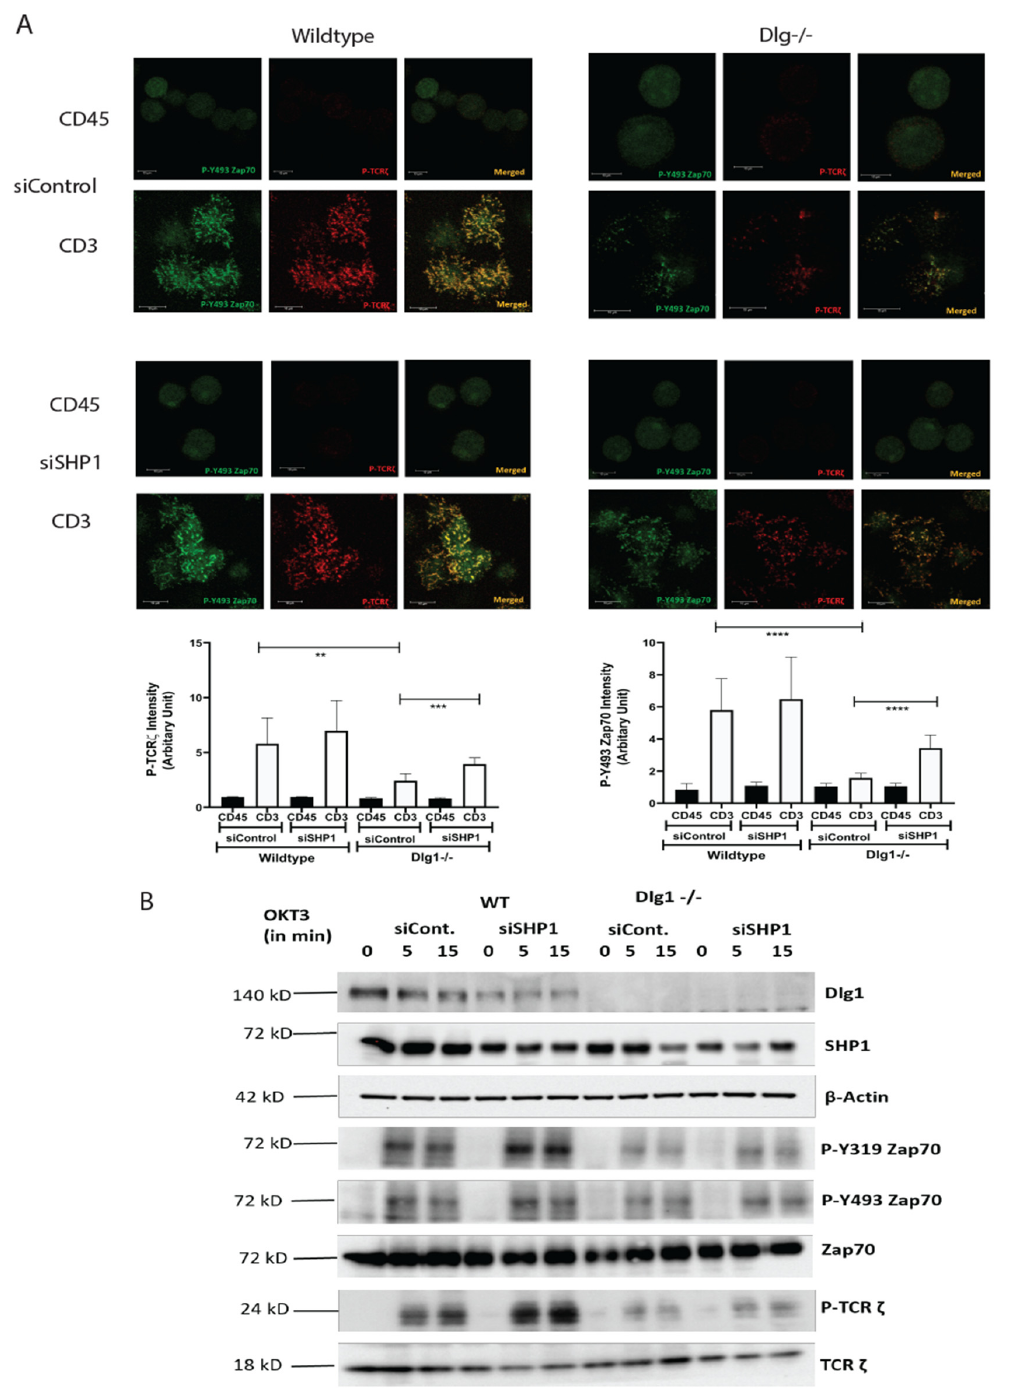
Figure 4. SHP1 knockdown partially rescues the inhibition of TCR-MC formation and proximal signaling conferred by DLG1 deficiency ( A ). Microclusters of phosphorylated Y493 ZAP-70 (green) and phosphorylated TCR- ζ (red) were visualized in immunostained wild-type or DLG1 KO Jurkat cells that were pretreated with control or SHP1-specific siRNA. Cells were dropped onto coverslips coated with anti-CD3 (stimulated) or anti-CD45 (unstimulated) and visualized after 5 min. Scale bars, 10 μ m. Quantitative data for specific signals’ intensities (using Image J; collected from eight fields) are graphically represented ( B ). Immunoblot analysis of lysates from wild-type and DLG1 KO Jurkat cells. Cells were pretreated with control or SHP1-specific siRNA, then activated with soluble anti-CD3 (monoclonal antibody OKT3) and antibody to mouse immunoglobulin G (IgG), followed by probing for phosphorylated and total proteins. Data are representative of three experiments. Student’s unpaired t tests were used for ( A ). ** p < 0.01, *** p < 0.001, **** p <